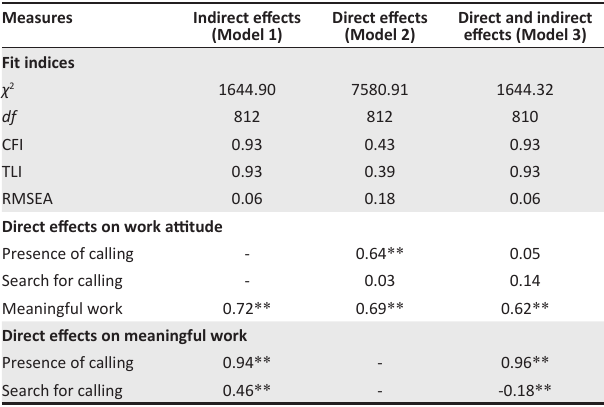
TABLE 5: Initial framework fit indices and standardised path coefficients. TABLE 6: Difference testing for competing structural models.